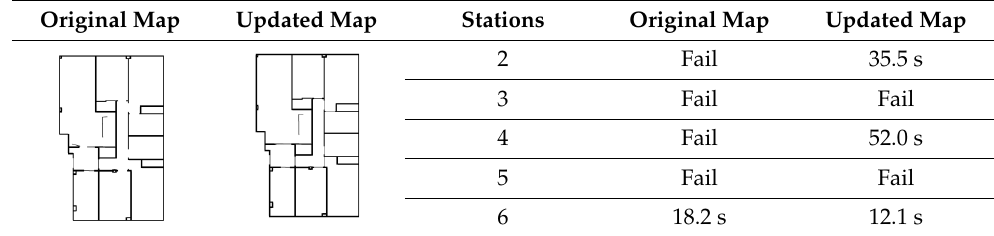
Table 4. Results of localization at stations 2 – 6, with the average time in seconds before accurate localization. Original Map